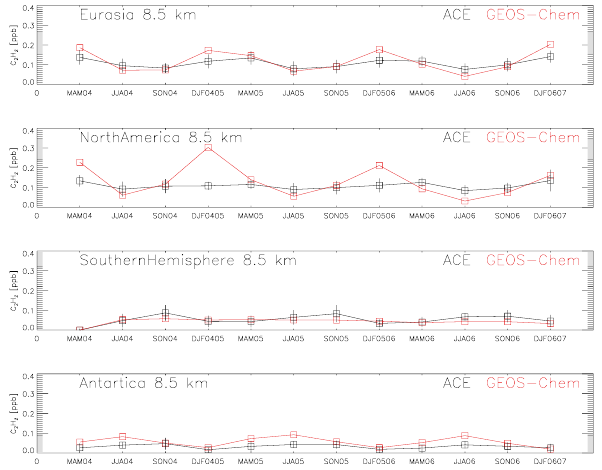
Fig. 14. Seasonal and hemispheric variations of C 2 H 2 volume mix- ing ratios observed (black) and simulated (red) averaged in different regions at